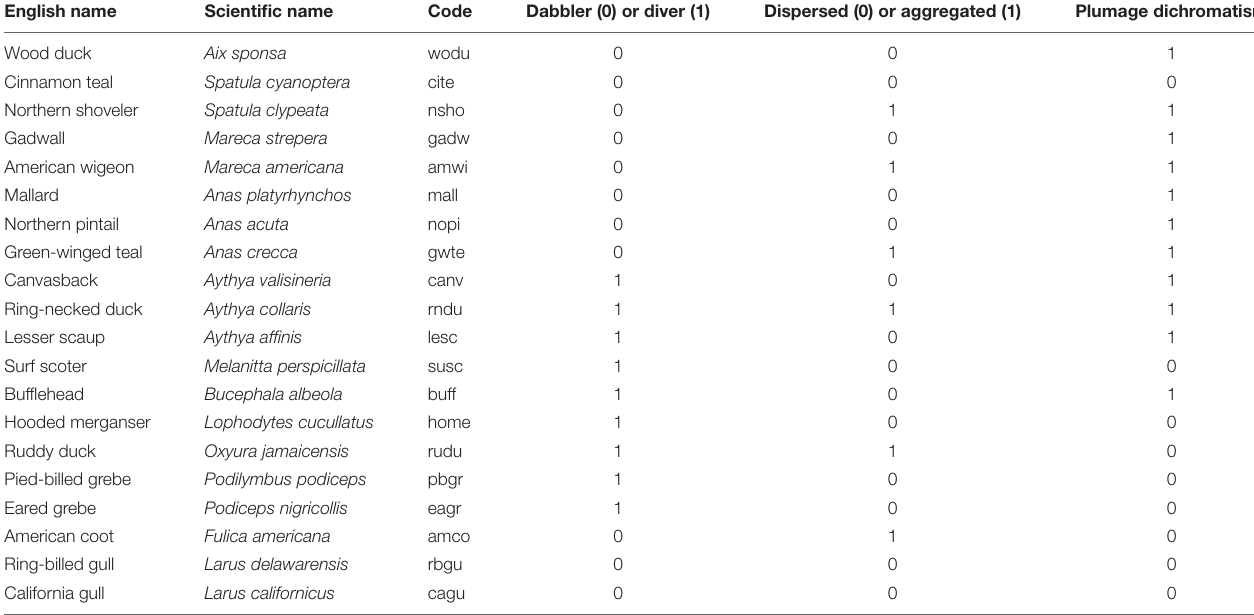
TABLE 1 | Twenty species were included in the study. Scientific names, sequence, and short-hand codes follow American Ornithological Society